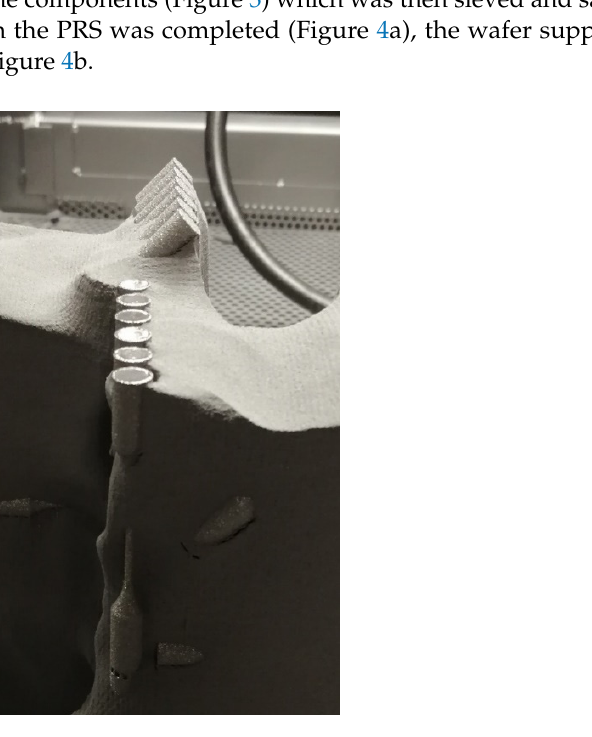
Figure 3. Post-running operation—depowdering of beam specimens in PRS.